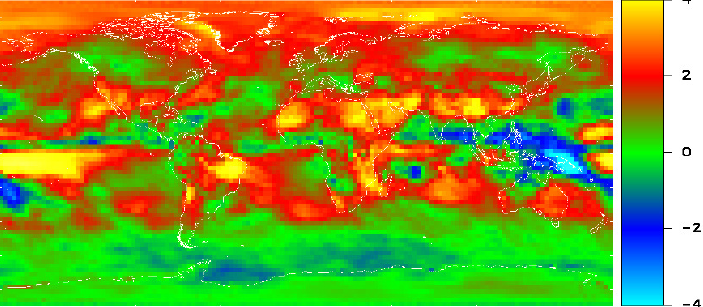
Figure 5. Change of HIRS OLR from 1985–2000 to 2001–2017. The scale is in W/m 2